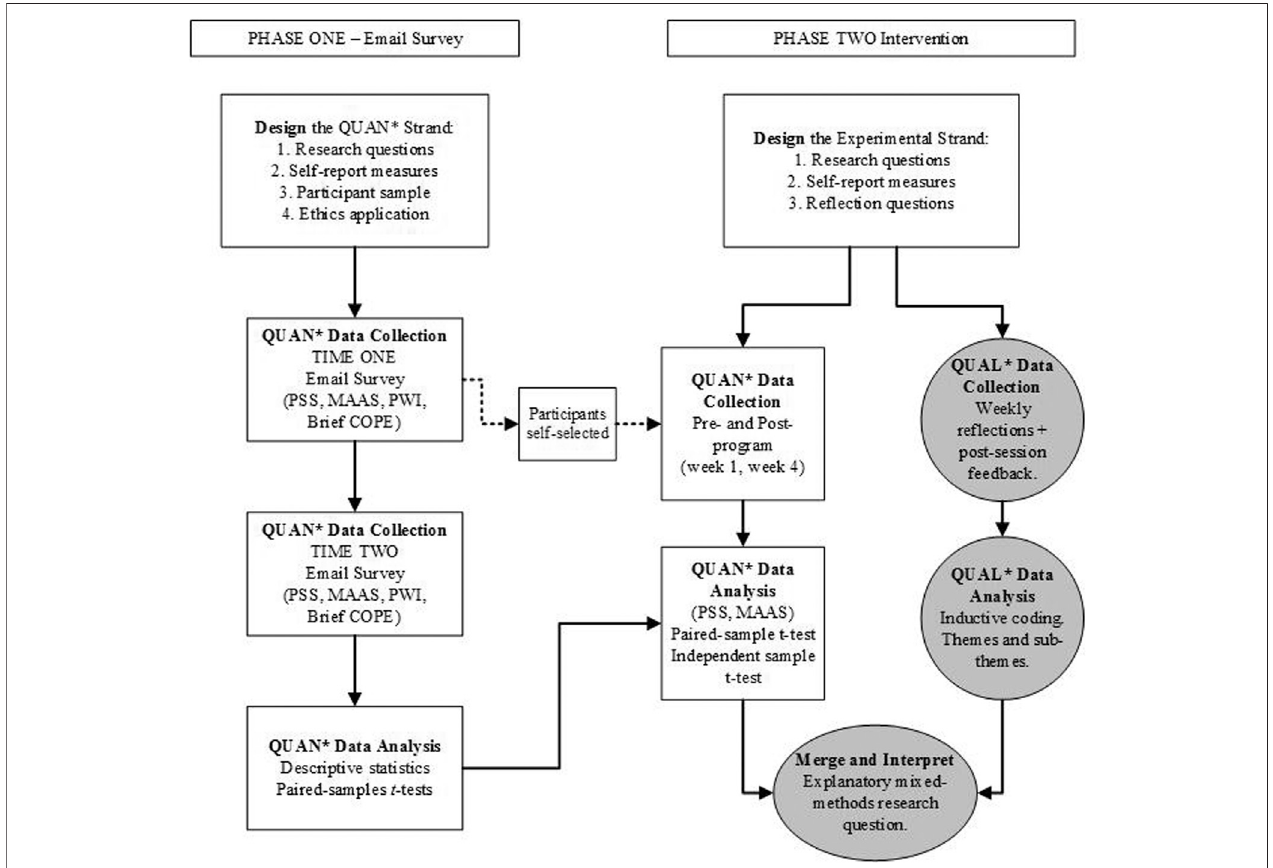
FIGURE 1 | Study design fl ow diagram, Phase One and Phase Two; QUAL*, qualitative, QUAN*,